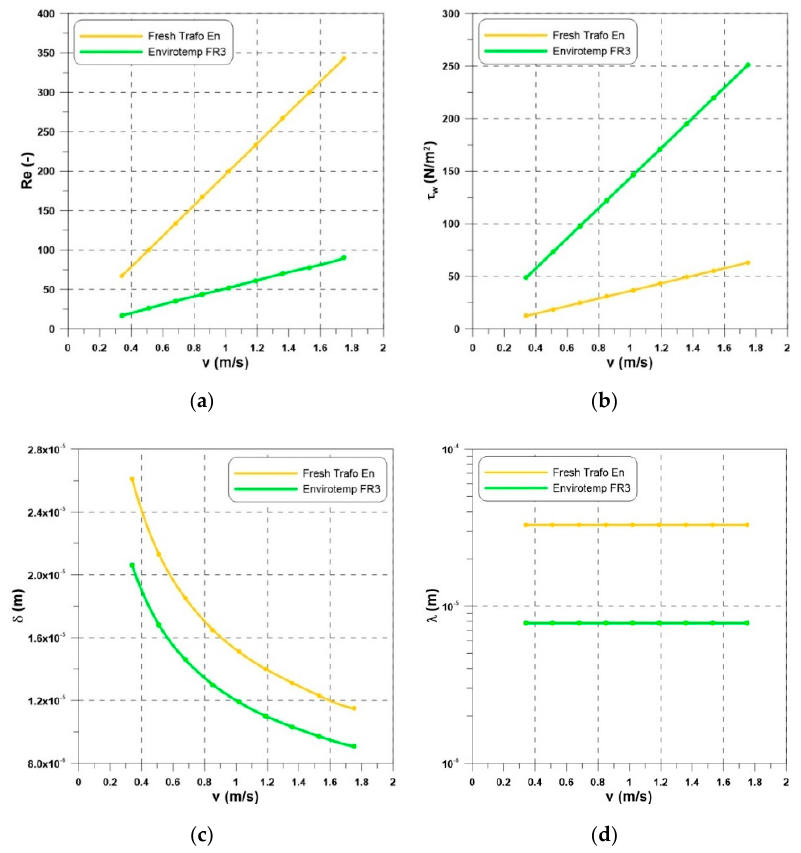
Figure 2. Selected parameters of the Abedian–Sonin model vs. flow velocity of insulating liquids: ( a ) Reynolds number; ( b ) shearing stress; ( c ) laminar sublayer thickness; ( d ) Debye length.